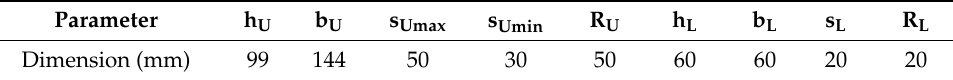
Table 2. Size of the design parameters in Figure 3.